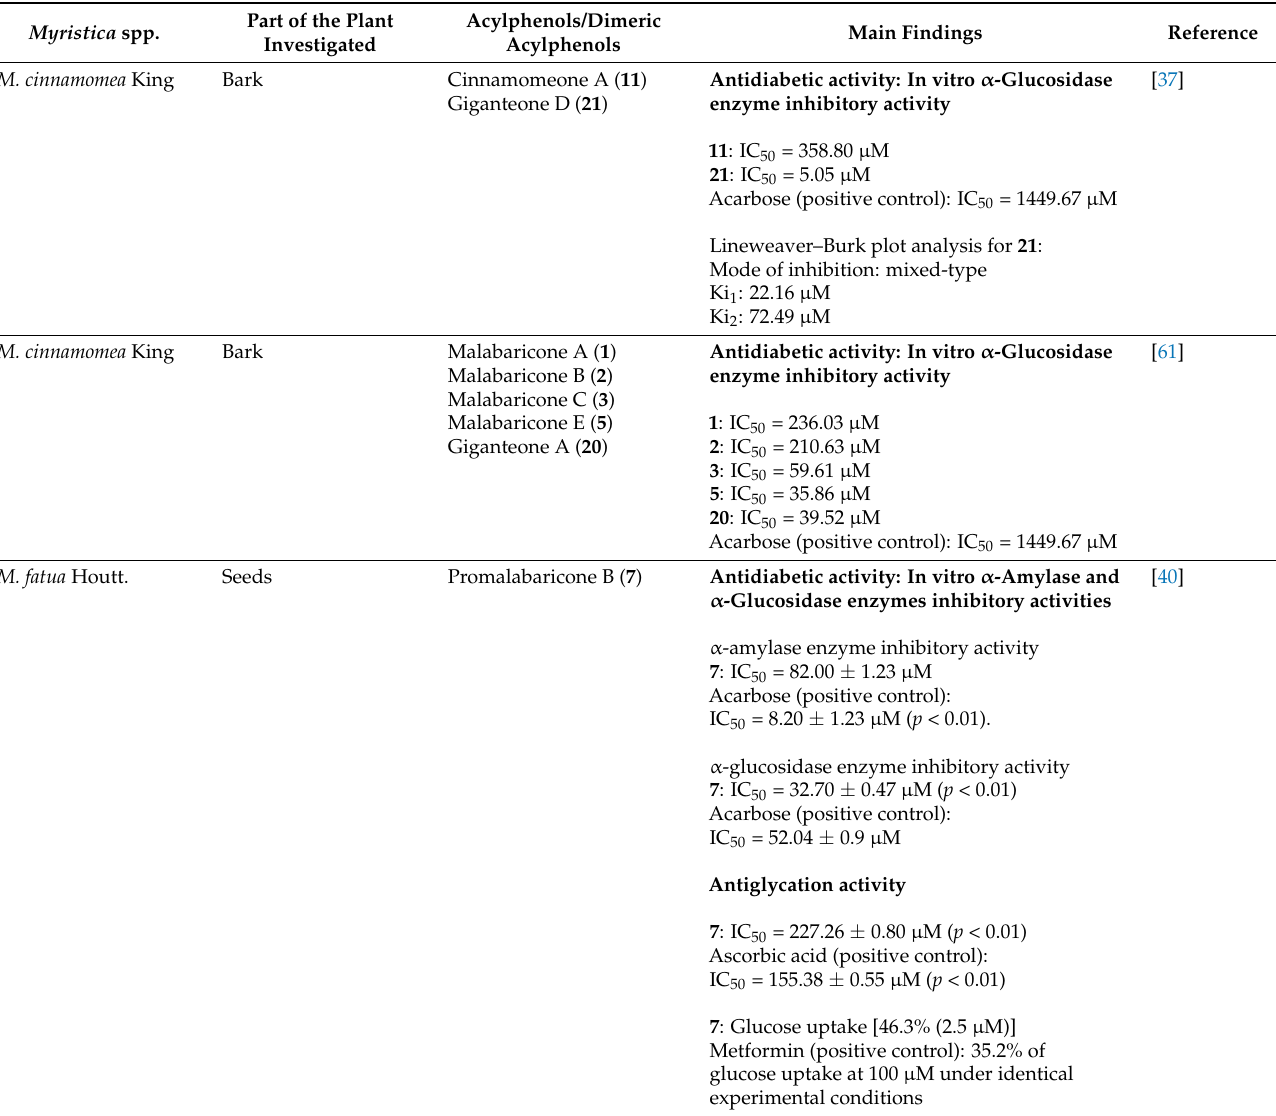
Table 7. The antidiabetic and antiglycation activities of acylphenols and dimeric acylphenols from the genus Myristica